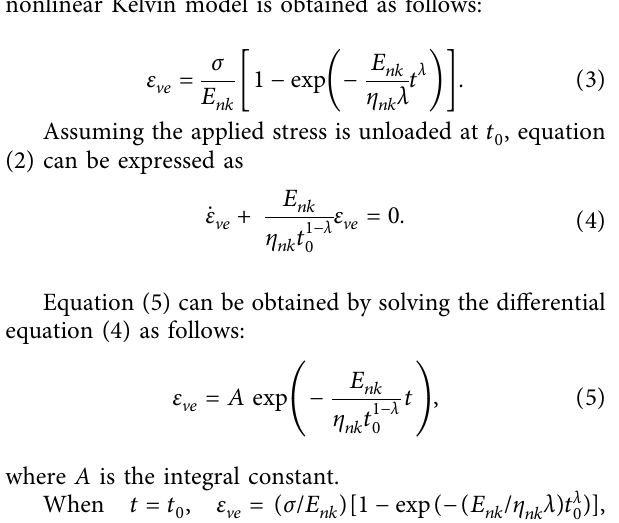
Figure 2: Nonlinear Kelvin